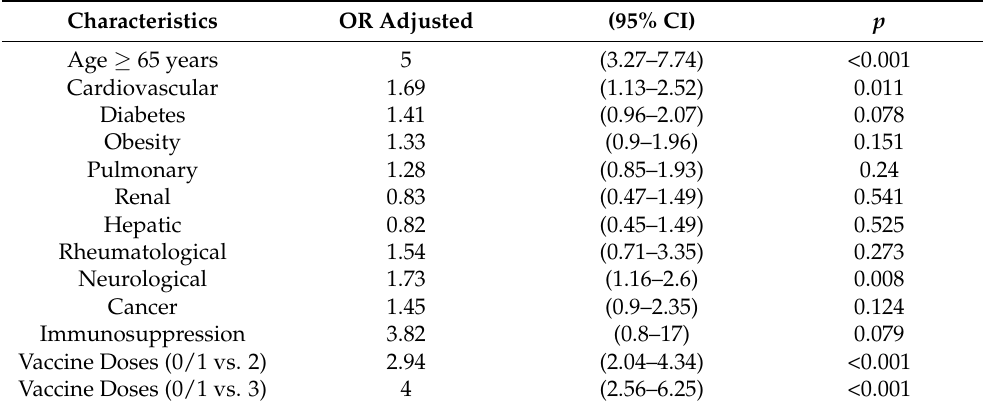
Table 6. Results of the multivariate logistic regression model predicting severe/critical COVID-19 during the fifth pandemic wave.